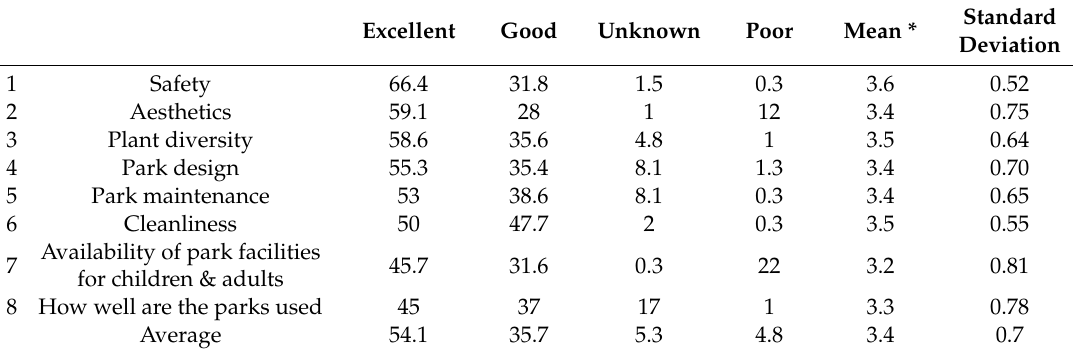
Table 5. Percentage value of residents’ attitude towards the quality of neighborhood